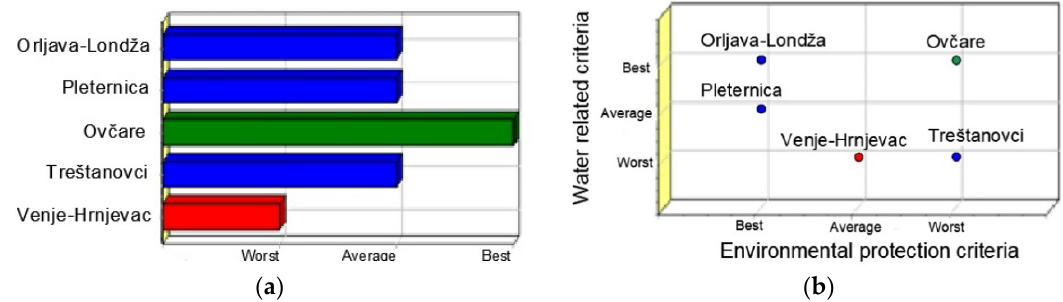
Figure 7. Presentation of results of DEXi application for Scenario 1: ( a ) result based on evaluation of all criteria, and ( b ) result for two criteria [23].